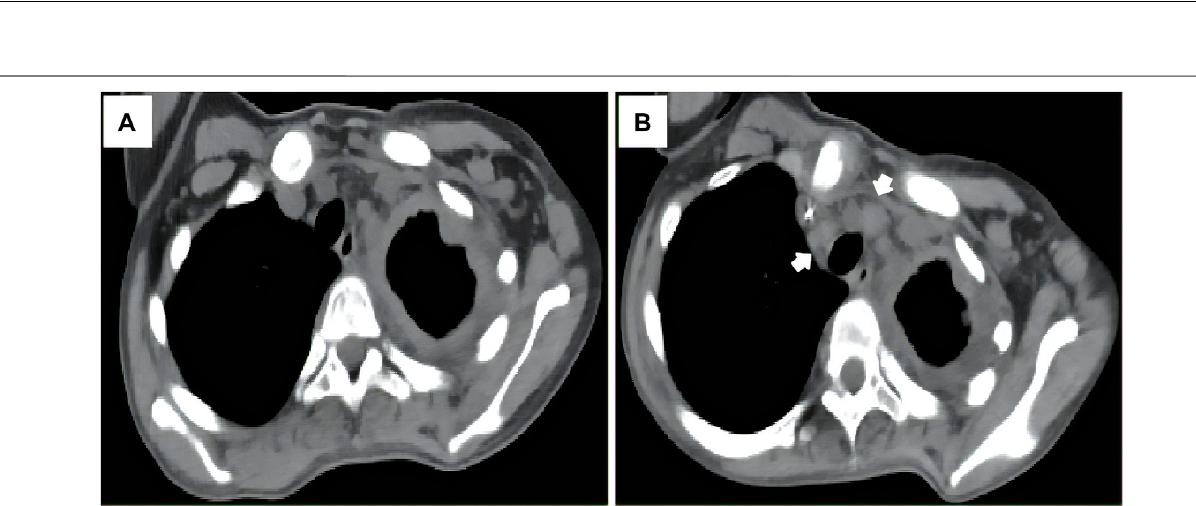
FIGURE3| Thetumor wascomposedofmultipleirregularvascularlacunae (A) .Thecavitywaslinedwithhobnailtumor cells (A) .Thetumor cellswere negative for CKpan (B) , but positive for ERG (C) . The positive expression rate of ki67 was 60% (D) .